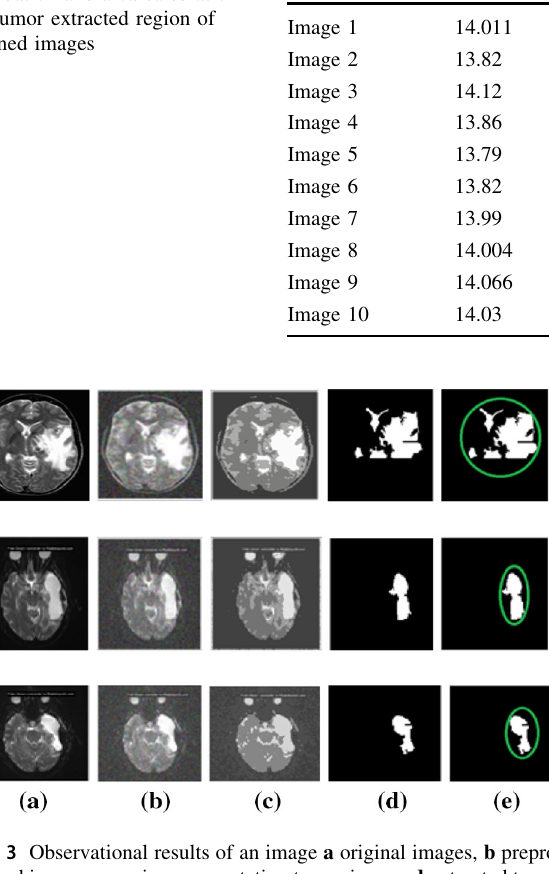
Table 3 The performance evaluation and area calculation of tumor extracted region of trained images